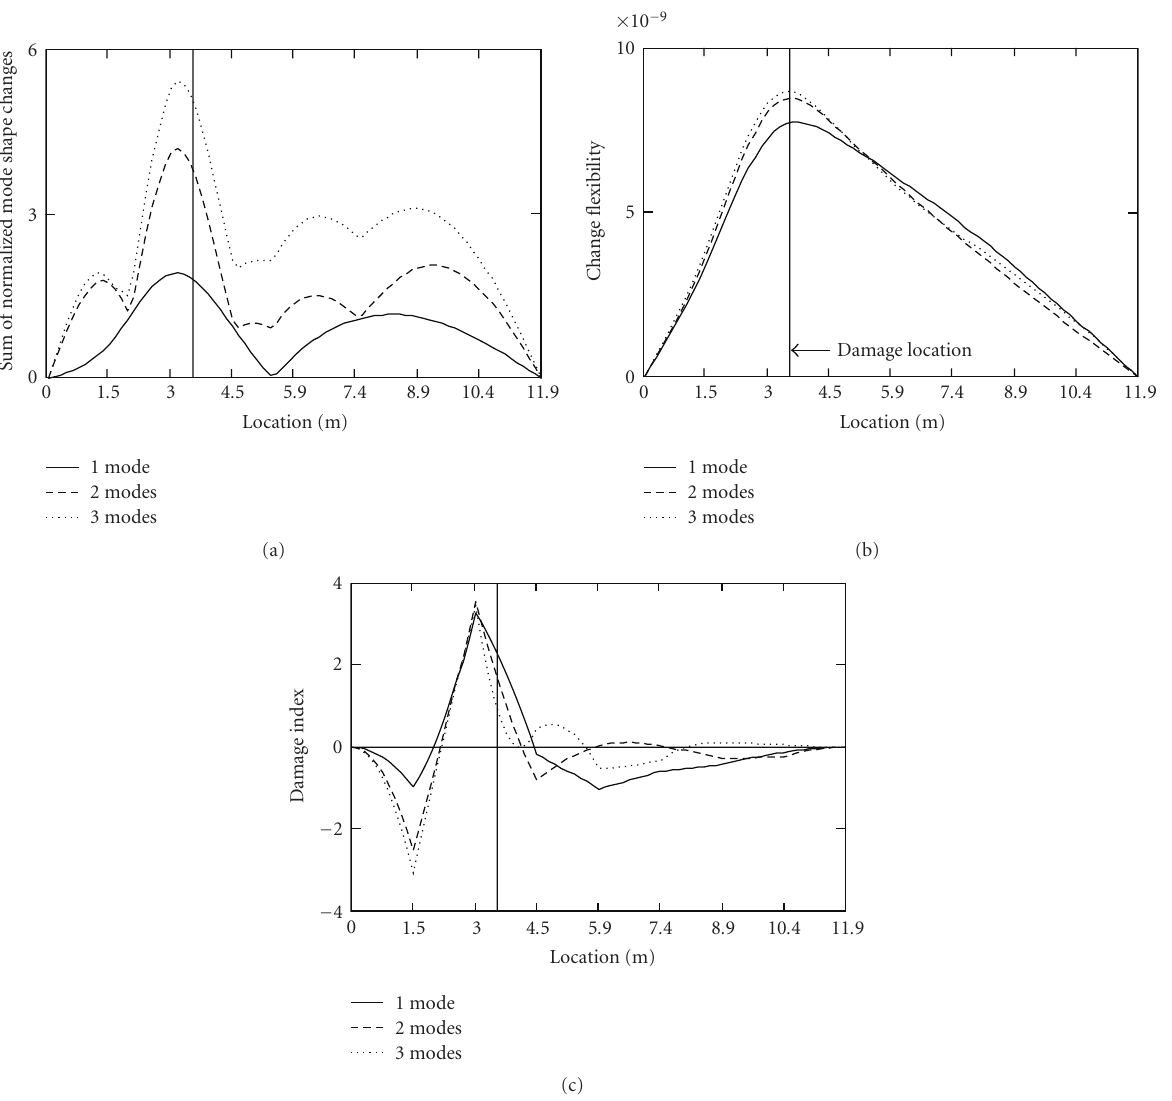
Figure 14: VBDD distributions calculated using the first three flexural modes and 7 measurement points for numerical damage case 24, located 3.50 m from the support, by the (a) CMS, (b) MCF, and (c) DI methods.